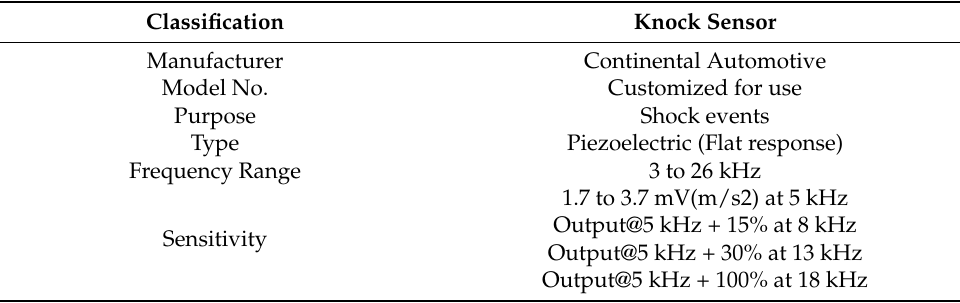
Figure 2. The vibration signal for each status in various operation conditions.